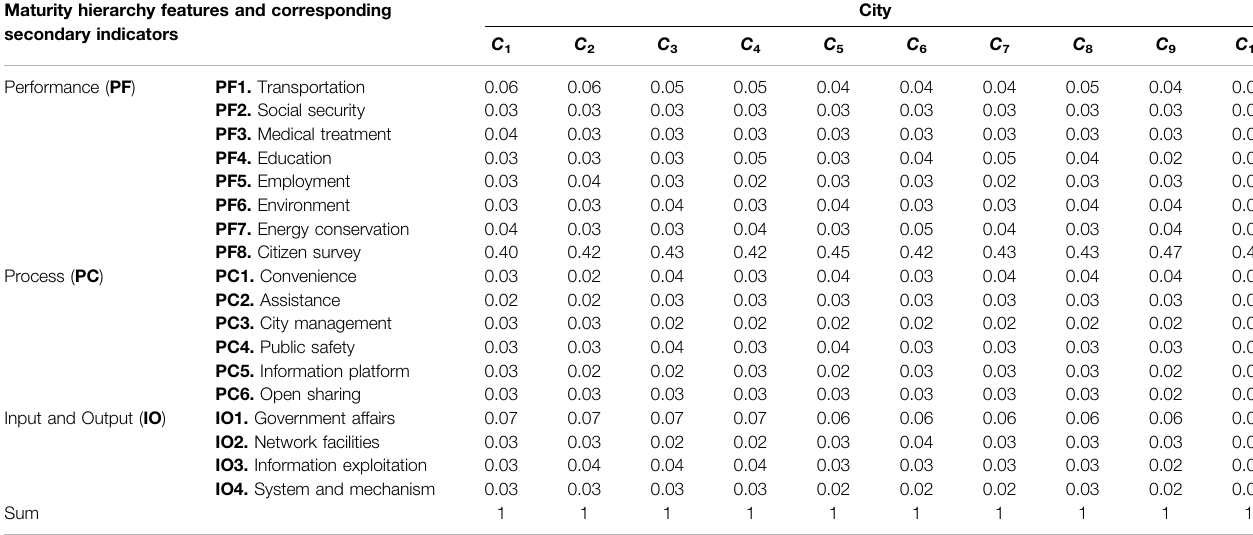
TABLE 5 | Indicators weights of ten